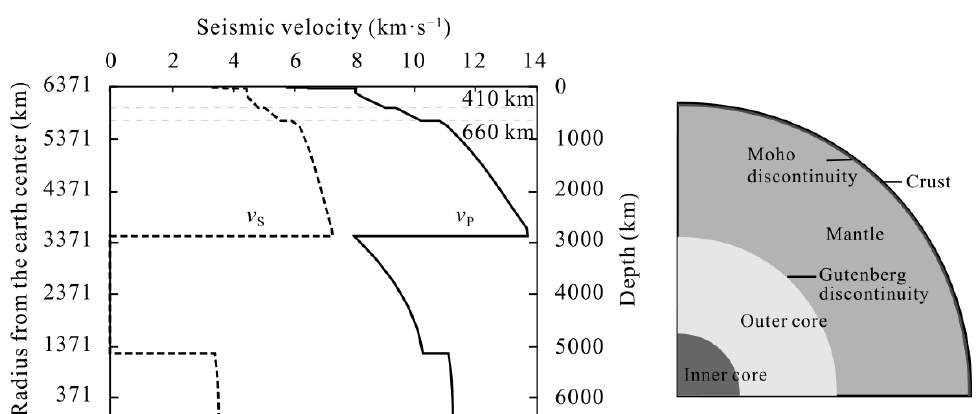
Figure 1. IASP91 Earth model. Table 1. The parameters of IASP91 Earth model.